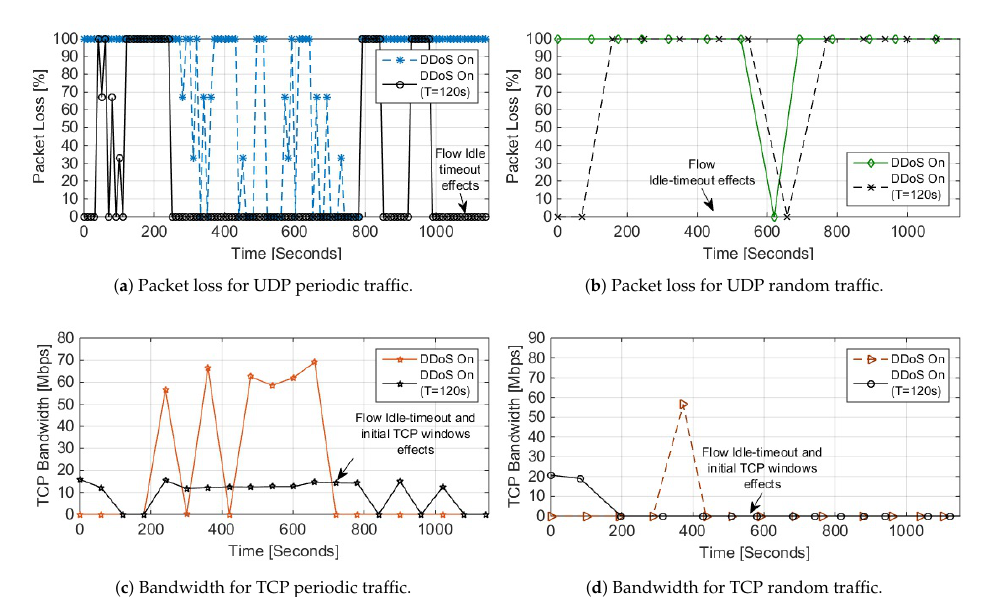
Figure 8. SDN-based IoT network performance under DDoS attack conditions with Idle_Timeout (120 s) and initial TCP window size (5000).